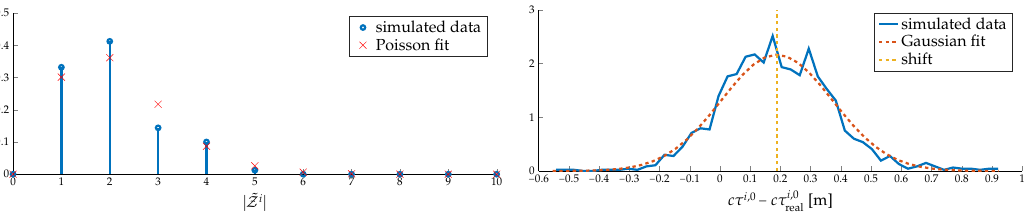
( f ) Histogram and Gaussian fit for p ( ˇ g i , l ∣ x